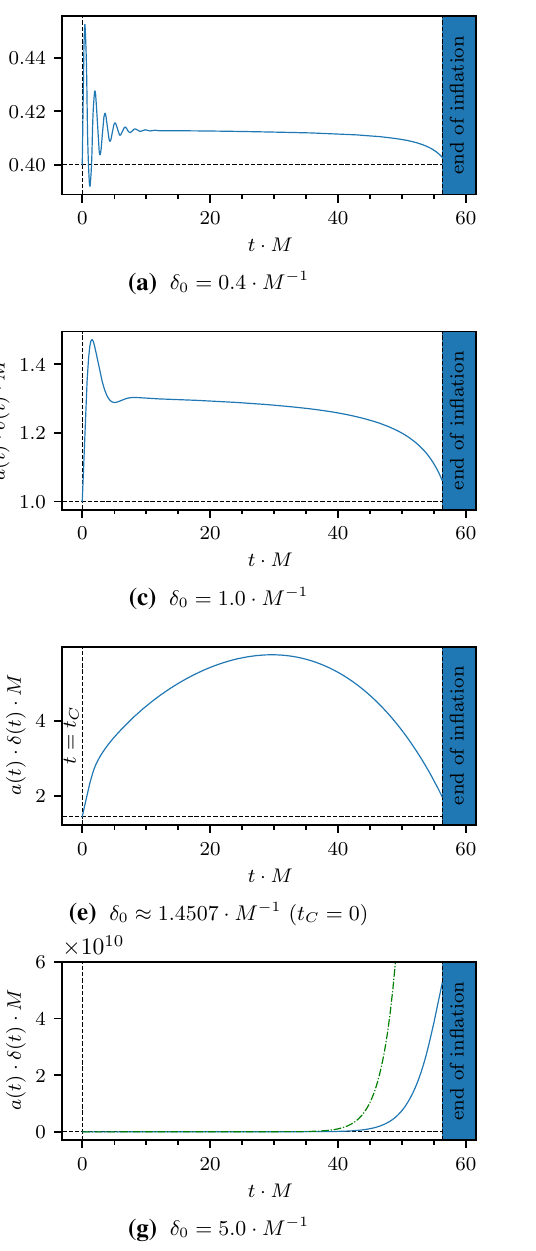
tical dashed line with the corresponding label. In Fig. 7e and 7f there is a vertical dashed line which corresponds to t = t C . In Fig. 7g, h there is a green (dash-dotted) line which corresponds to a ( t ) · δ 0 ·